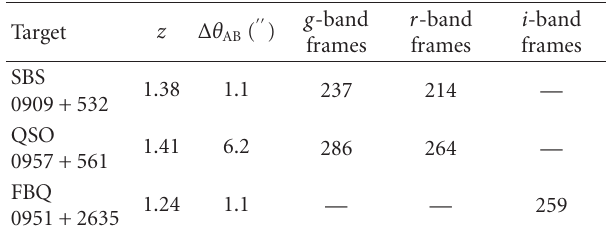
Table 1: LQLM I optical